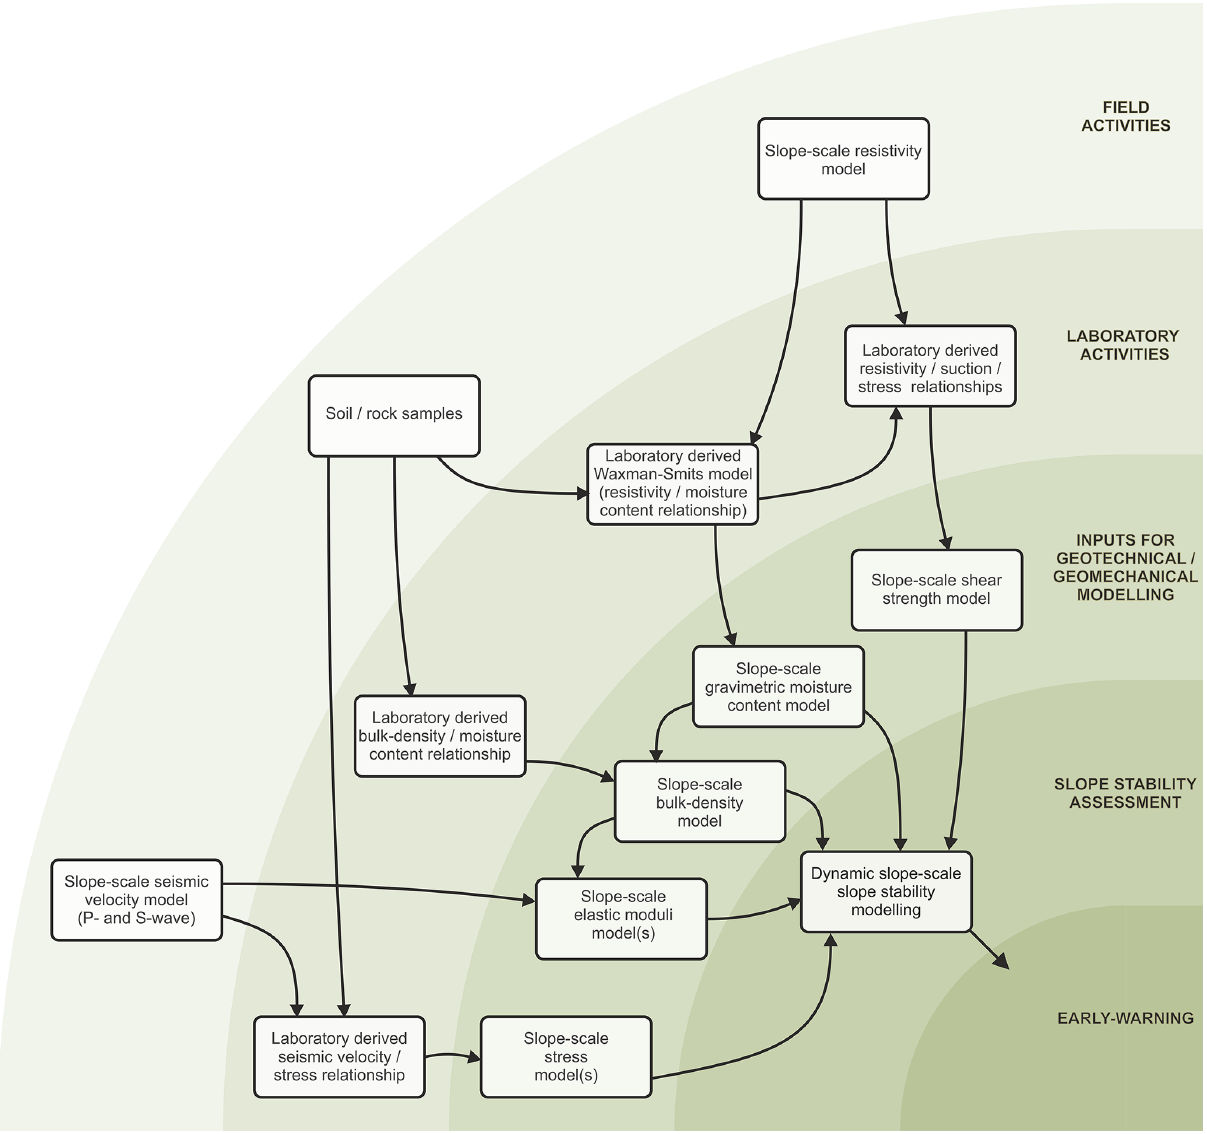
Figure 3. A proposed roadmap, developed for the Hollin Hill Landslide Observatory (HHLO) in the UK, for moving from geophysical and geotechnical field measurements to landslide early warning by using laboratory measurements to transform geophysical data for slope-scale